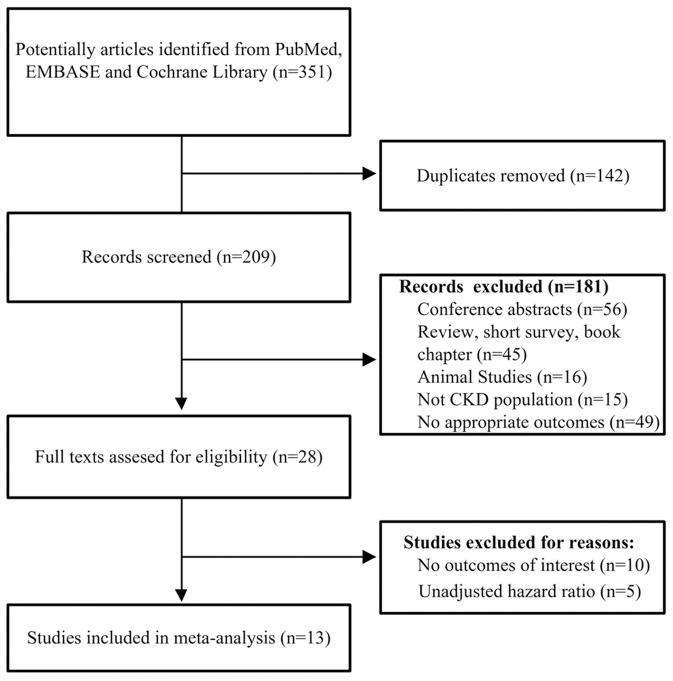
Flow chart of the study selection process.